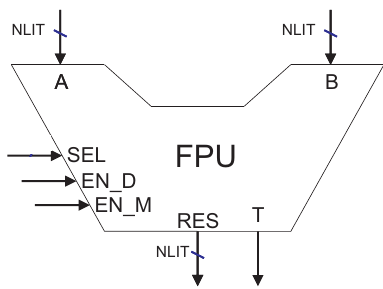
Figure 8. Logic block of the floating point unit.